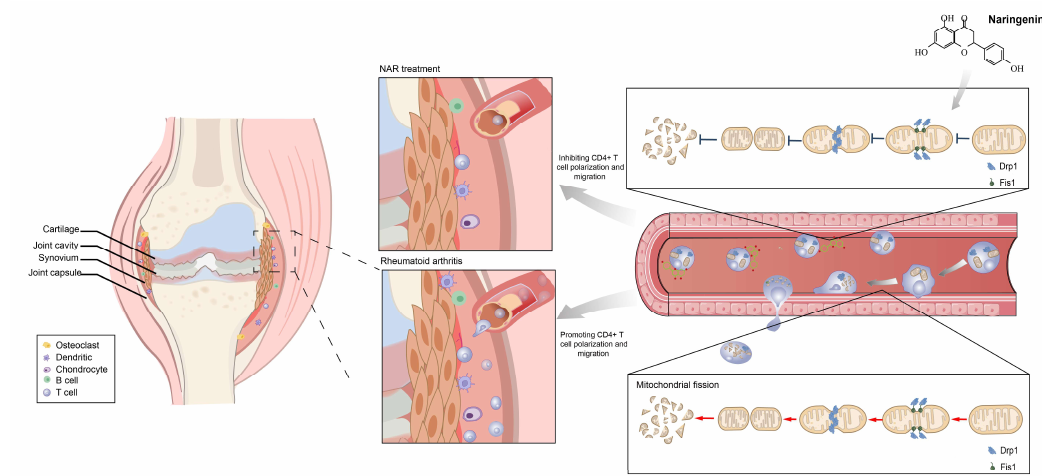
Figure 10. The mechanism of Naringenin alleviates CIA by curbing the migration and polarization of CD4 + T lymphocytes driven by regulating mitochondrial fission.